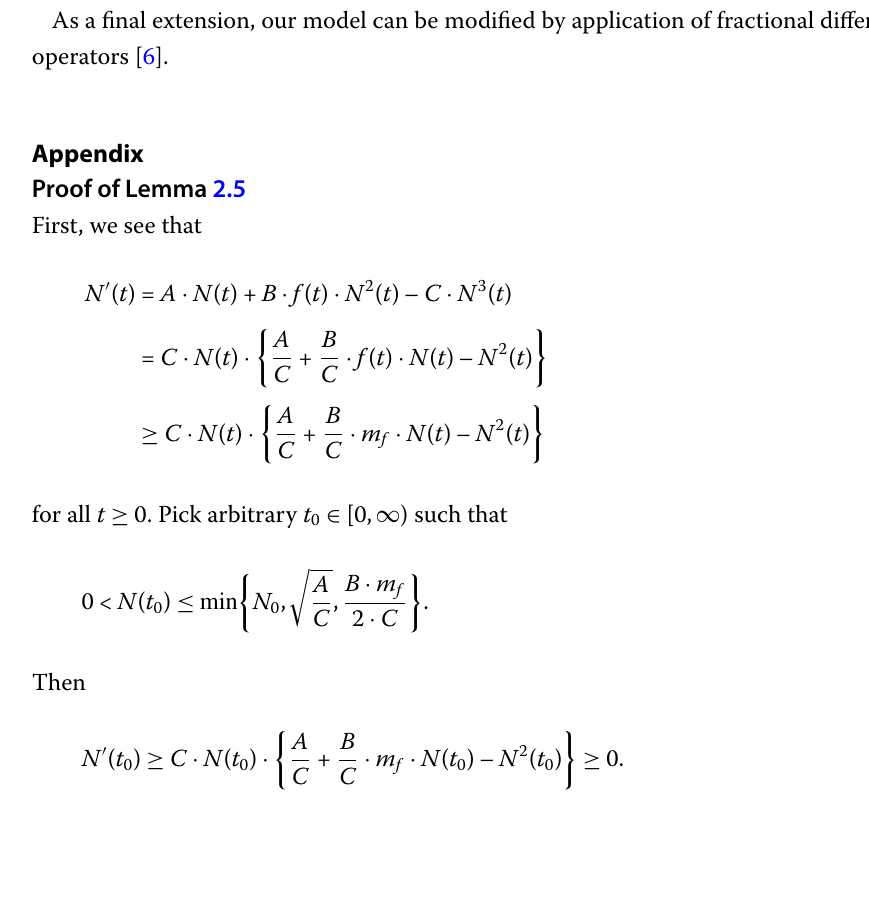
a delicate task [1, 11, 12, 47]. However, more sophisticated techniques for solving inverse problems are out of the scope of this